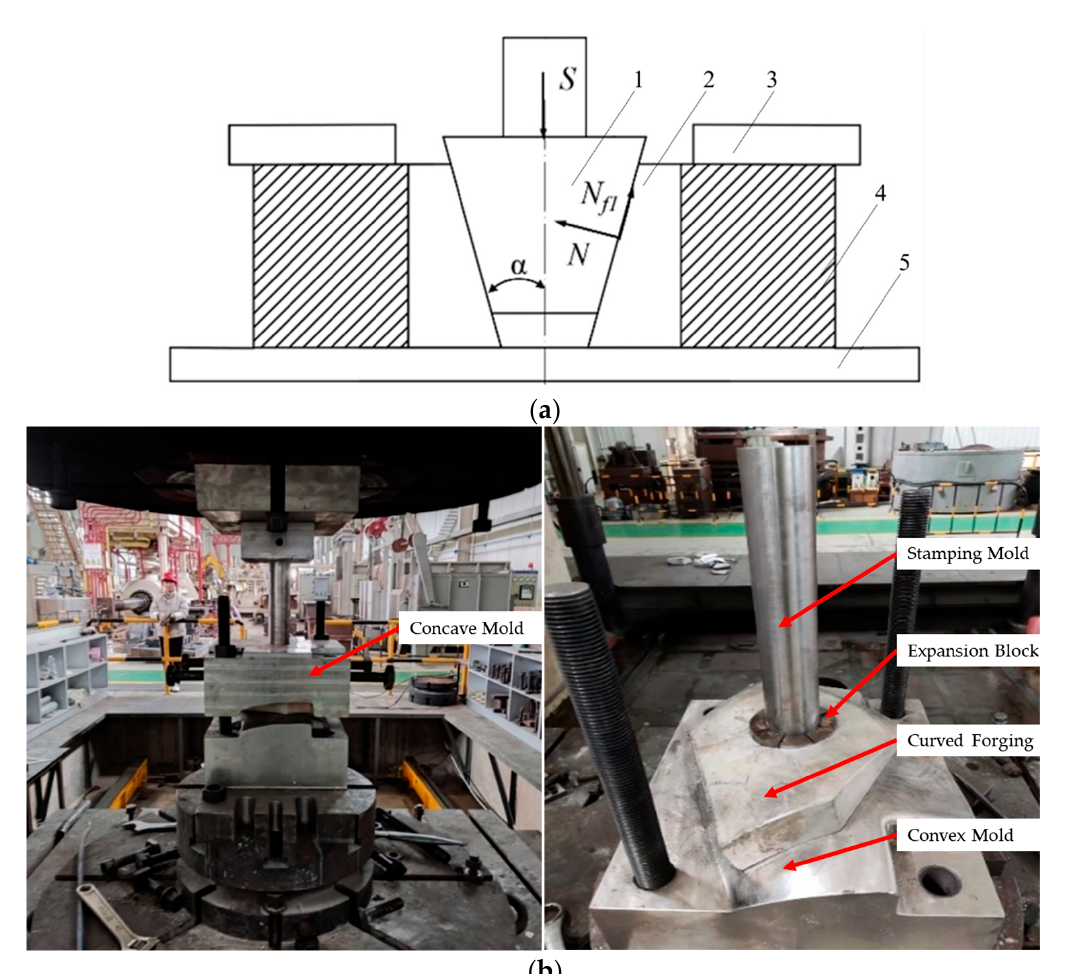
Figure 2. Cold expansion of forging: ( a ) schematic diagram: 1- stamping mold; 2- expansion block; 3- concave mold; 4- curved frame forging; 5- convex mold; ( b ) experiment.